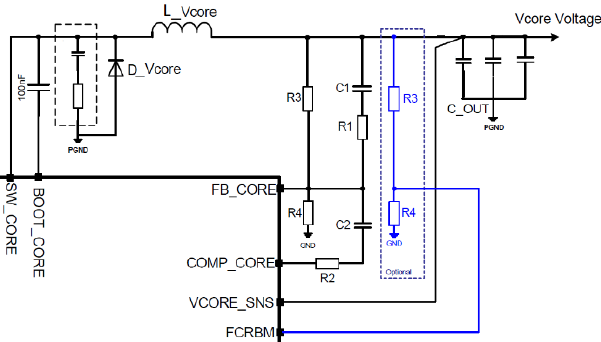
Figure 5. F6512 SBC 5 V, V CORE design. Reproduced from [1].